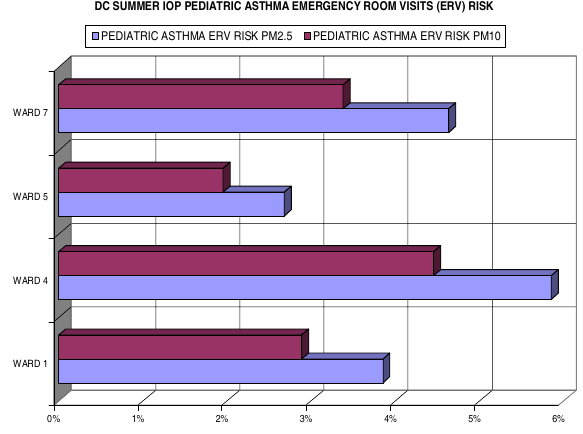
Figure 7: Summer IOP Pediatric Asthma ERV Excess Risk